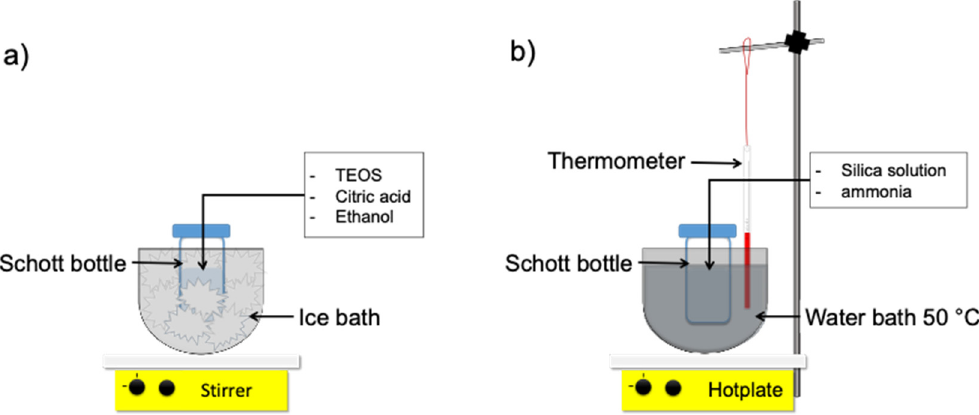
Figure 1. Schematic of organo-silica sol–gel process set-up ( a ) mixing process at 0 °C ( b ) mixing process at 50 °C.